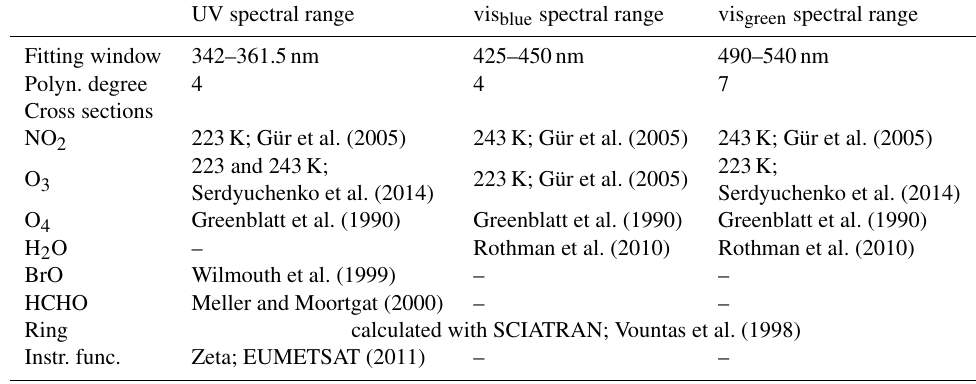
Table 1. Fit settings for the NO 2 retrievals in the UV and the vis spectral